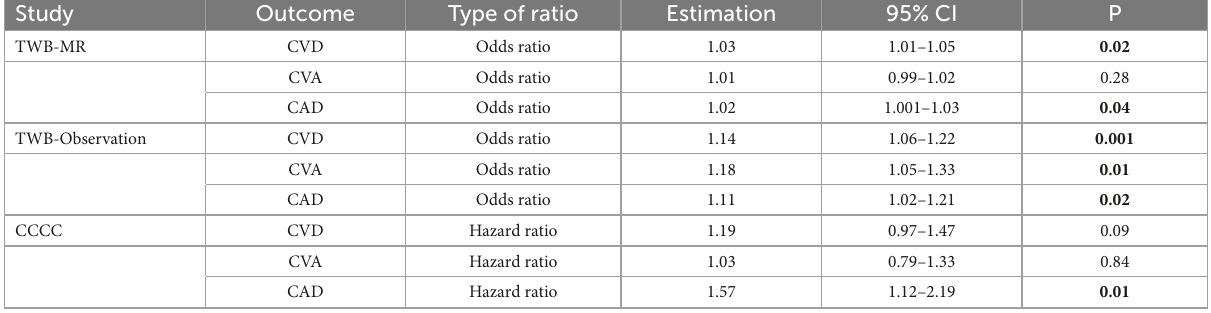
TABLE 2 Effects of one standard deviation earlier age at menarche on the risk of cardiovascular disease.